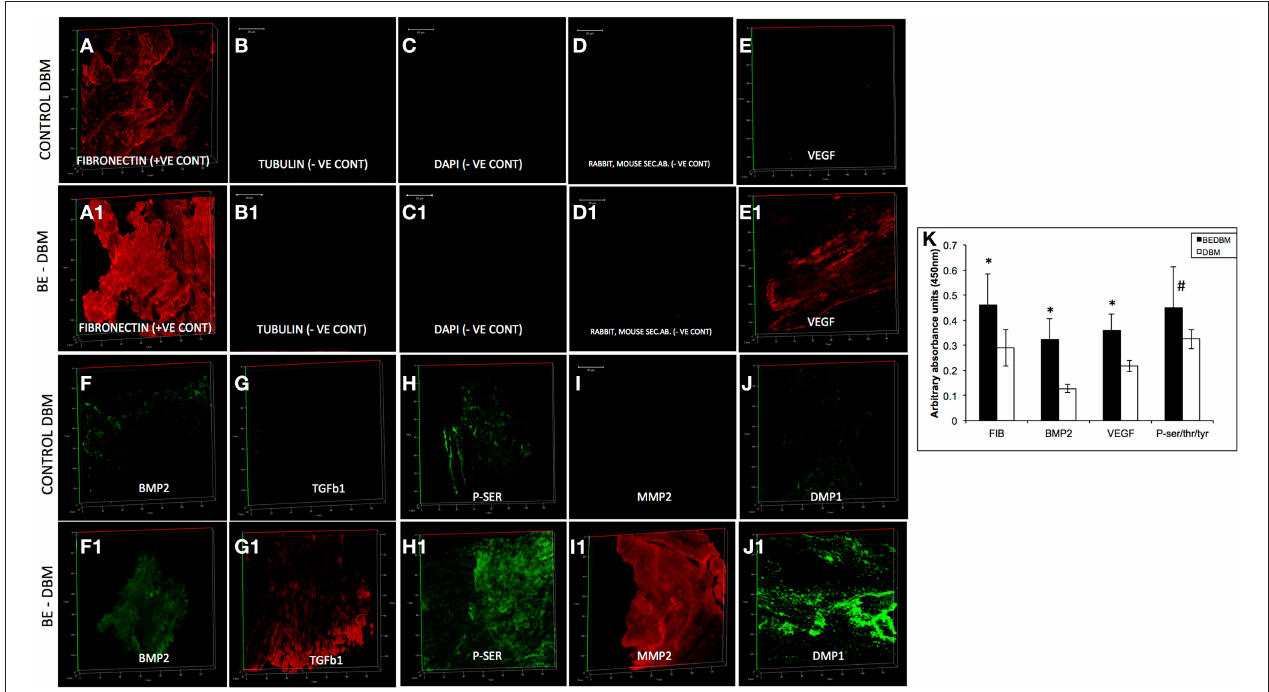
FIGURE 1 | ECM proteins in DBM and BE-DBM. Images compare the expression of representative ECM proteins in DBM (A–J) and BE-DBM (A1–J1) . All images except B,B1,C,C1,D , D1 (scale bar represents 20 µ m for these images) are 3D renderings of z-stack confocal images. Tubulin (B,B1) was used as a negative control for absence of intracellular proteins and DAPI (C,C1) nuclear staining was used as negative control for absence of cellular DNA. Immunostaining was performed for Fibronectin (A,A1) , VEGF (E,E1) , BMP2 (F,F1) , TGF β 1 (G,G1) , proteins containing phosphorylated serines (H,H1) matrix metalloproteinase 2 (MMP2, I,I1 ) and DMP1 ( J,J1 ). Panel (K) is a graphical representation of the relative amounts of select ECM proteins in both DBM and BE-DBM ( n = 4 ). The quantified proteins were: Fibronectin (FIB), BMP2, VEGF, and phosphorylated proteins (P-ser/thr/tyr). Statistical significance was measured using student’s t -test. * Represents statistical significance with P < 0.05 and # represents statistical significance with P < 0.1 . Phosphorylated proteins were quantified using an antibody that recognizes phosphorylated serine, threonine and tyrosine residues.